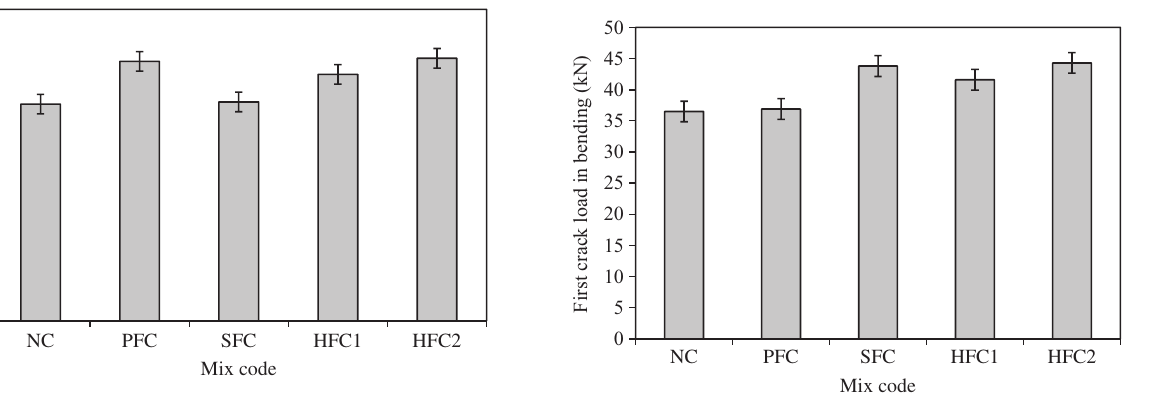
Figure 2 Flexural tensile strength for different fi ber contents. Figure 3 First crack load in